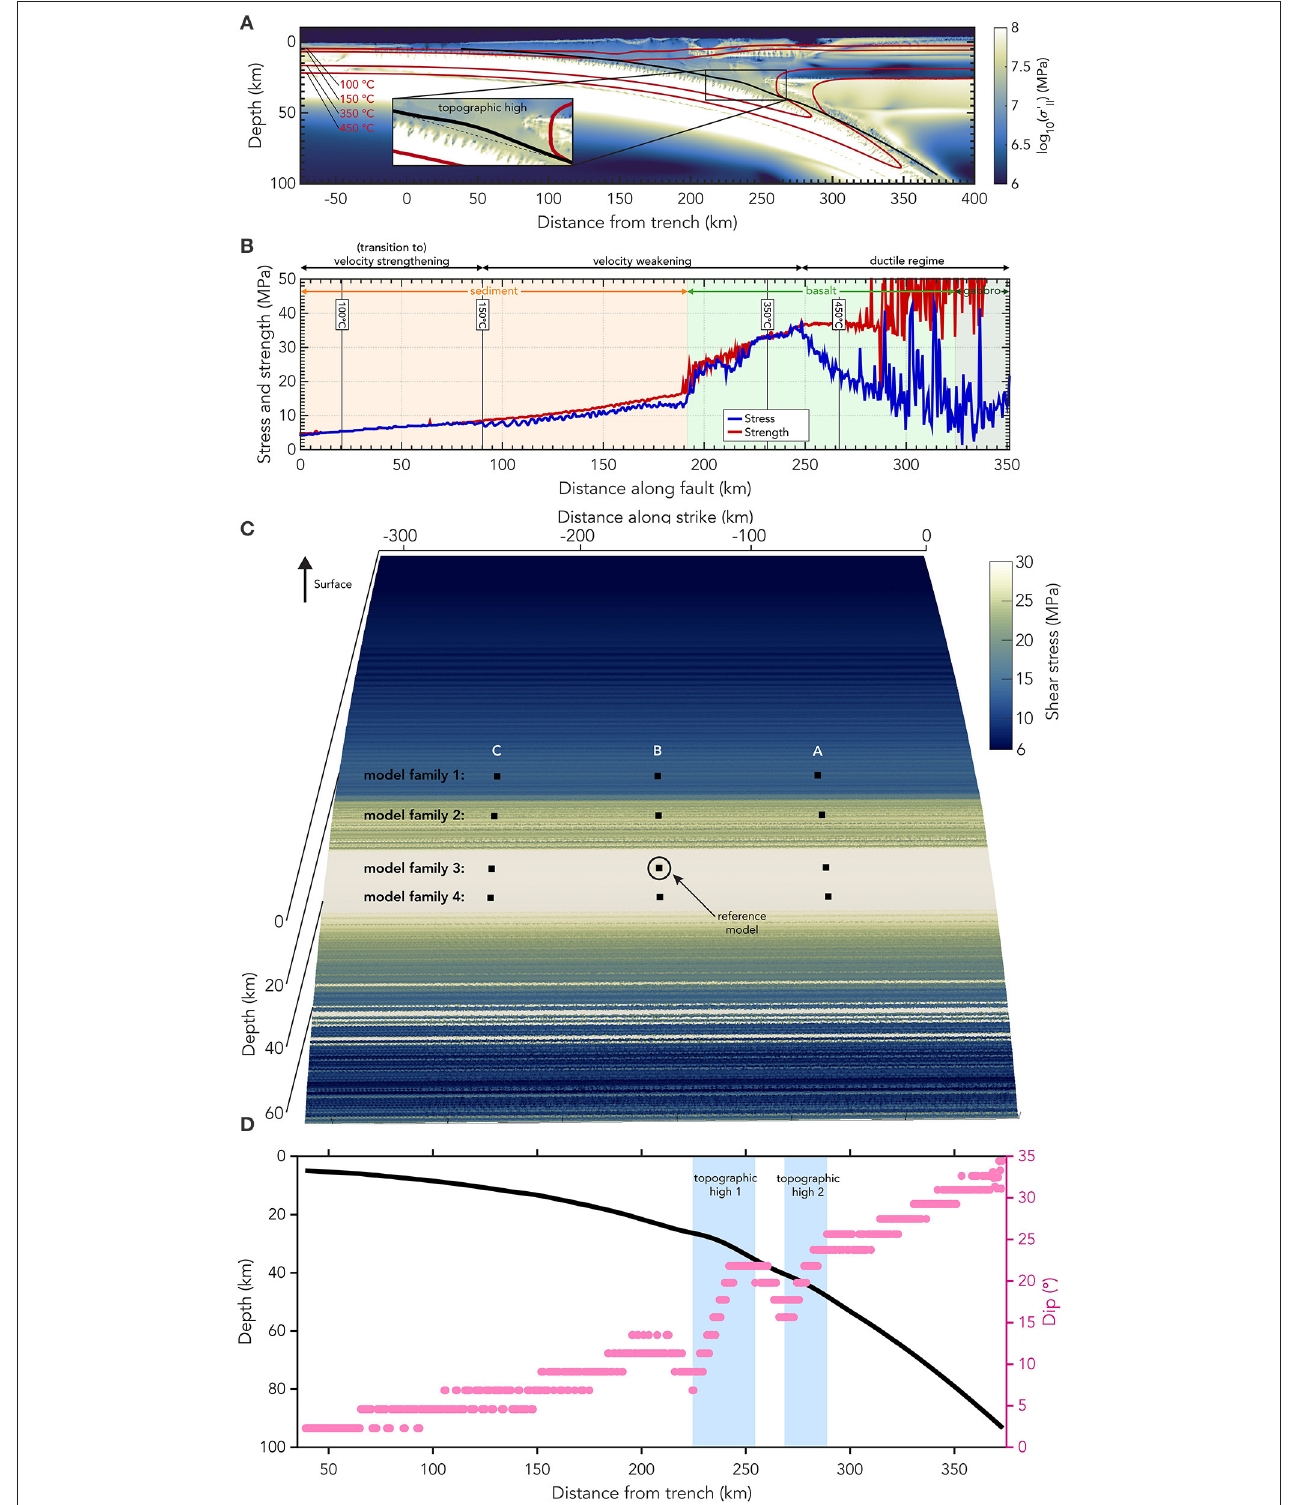
FIGURE 2 | Subduction model initial conditions for the dynamic rupture earthquake simulations. (A) Snapshot of stresses evolving during the 2D long-term geodynamic subduction and seismic cycle simulation at the time-step right before a slip event occurs (adapted from van Zelst et al., 2019). The stresses are expanded to the third dimension assuming plane strain conditions. (B) On-fault shear stress and fault strength in the SC model at the coupling time-step. The fault